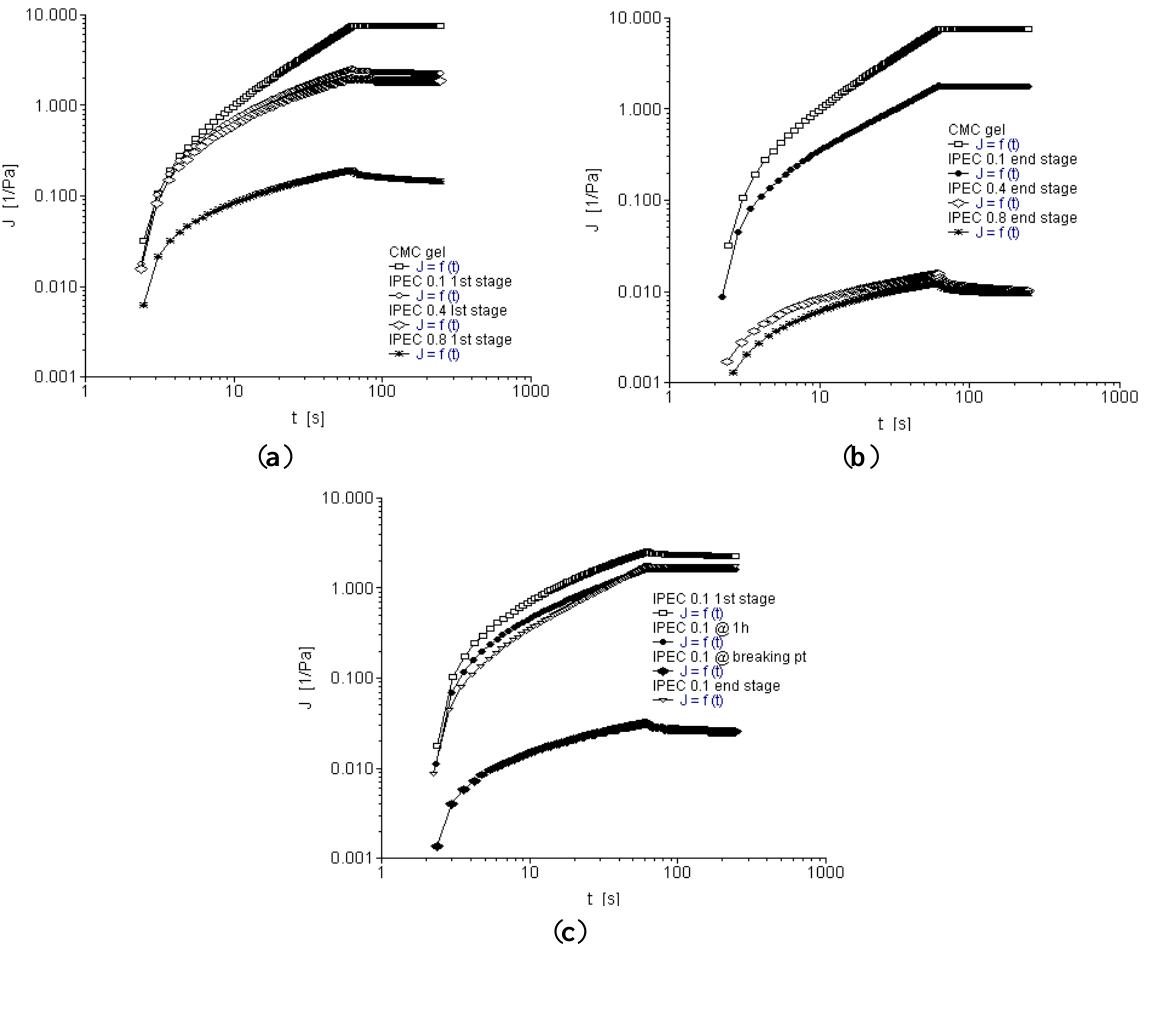
Figure 7. Creep recovery rheogram for ( a ) NaCMC and IPEC at 1st stage of synthesis; ( b ) NaCMC and IPEC at end stage of synthesis; and ( c ) IPEC 0.1 N at the 4 sampling points of